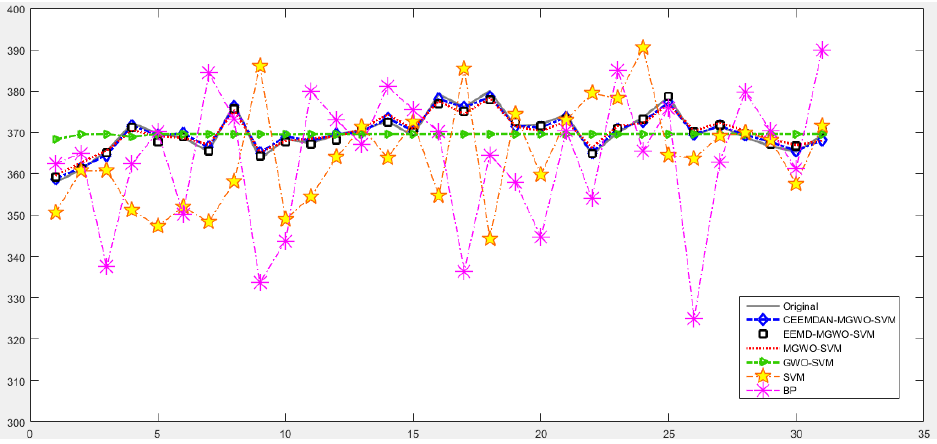
Figure 9. Comparison of forecasting results.